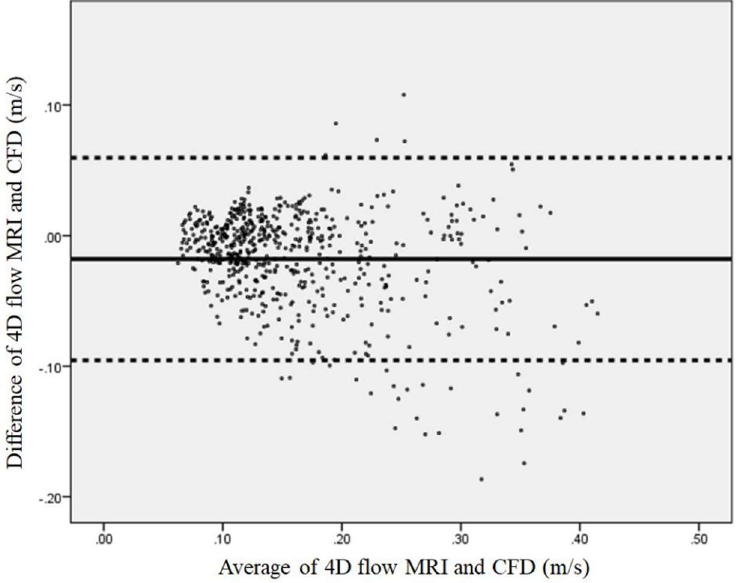
Figure 4. Bland–Altman plot analysis of 14 carotid bifurcation velocity data ( n = 606) comparing results of mean blood flow velocity over the cardiac cycle for all 4D flow MRI with ITK-SNAP and CFD analysis planes. The solid line indicates the mean of the difference between 4D flow MRI and CFD. The dashed lines represent the limits of agreement between the two methods, from −1.96 to +1.96 of standard deviation (limit range from −0.095 to 0.060 m/s).